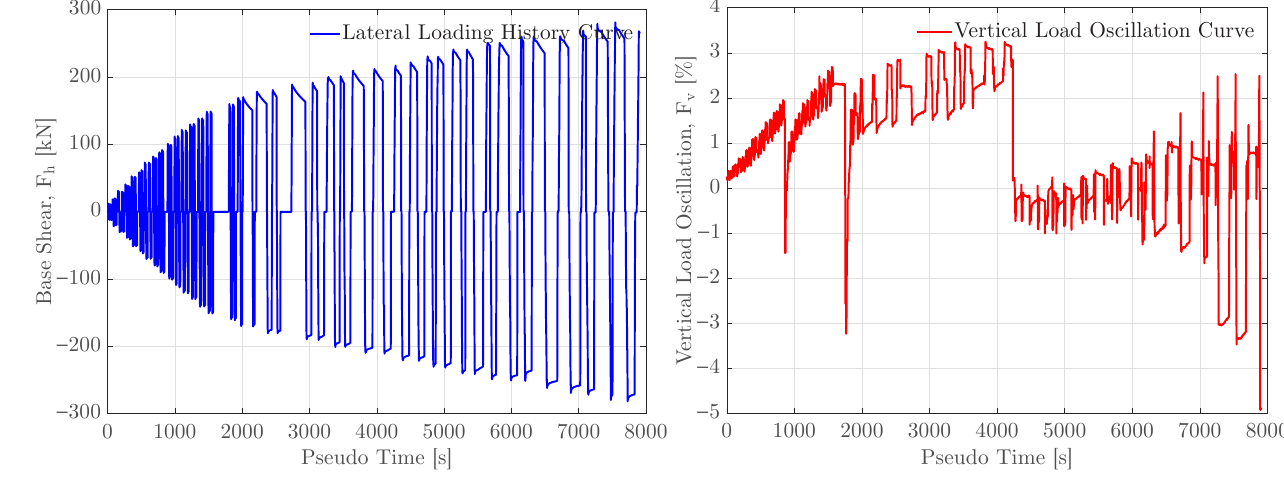
Figure 4. Time-history of the applied lateral cyclic ( left ) and vertical load ( right